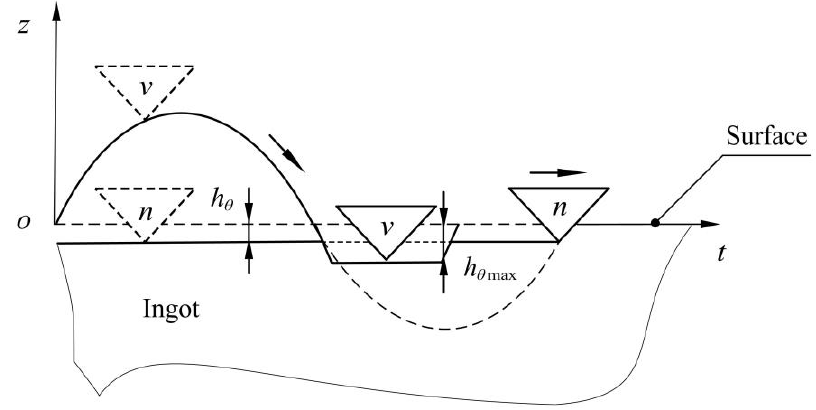
Figure 4. Schematic diagram of the wire cross-section.